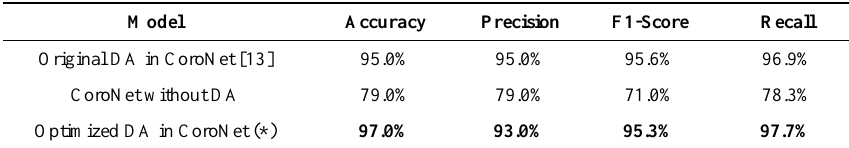
Table 10. Evaluation metrics of the proposed CoroNet with the optimized data augmentation strategy (*) and competing state- of-the-art models on COVID-19 classification on dataset 1. The values presented are as reported in the published papers.